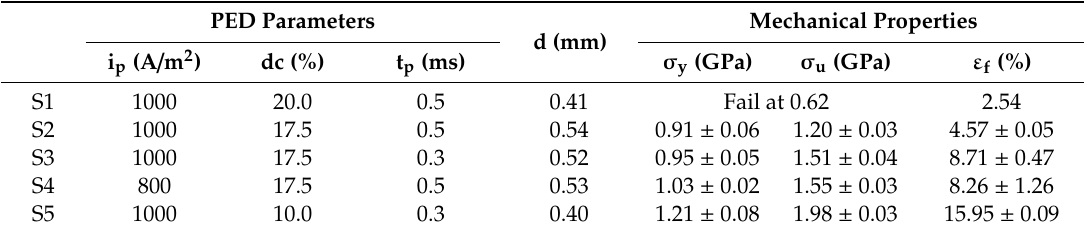
Table 2. The yield strength ( σ y ), ultimate tensile strength ( σ u ), and total elongation at fracture ( ε f ) of tensile specimens S1–S5 with different thicknesses (d) measured from the engineering stress–strain curves in Figure 2b. Two tensile specimens were mechanically tested for S2–S5.